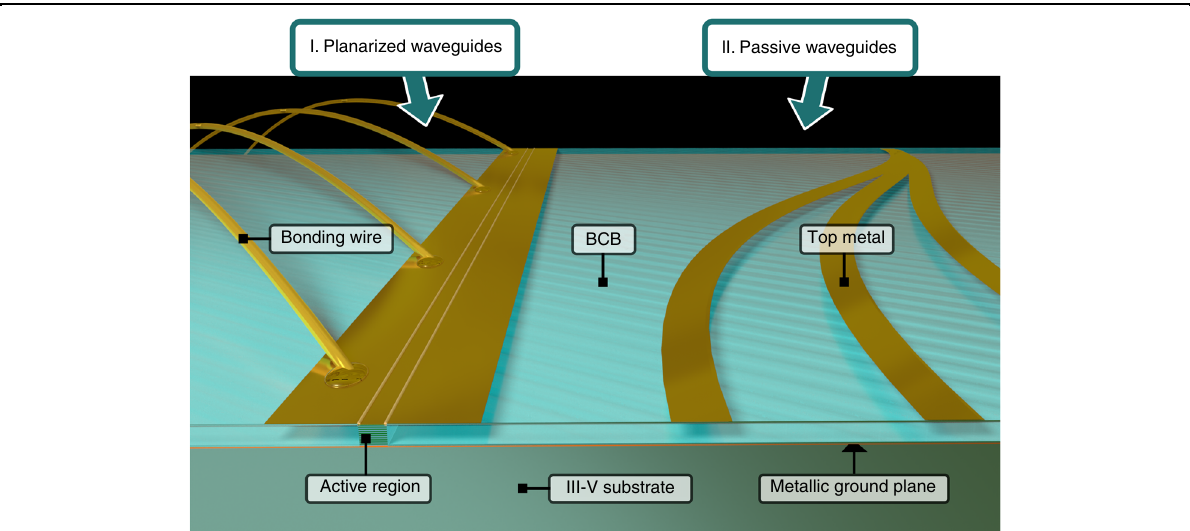
Fig. 1 Our new platform for broadband coherent THz photonics is based on planarized active and passive waveguides embedded in BCB, a low-loss polymer. I . The planarized active waveguide consists of a standard double metal waveguide encompassed in BCB and an extended top contact metallization, which enables narrower active ridge geometries and the placement of bonding wires over the passive section. This con fi guration preserves the low waveguide losses of double metal waveguides while improving the dispersion, RF and thermal properties (see text for details). II . Passive waveguides can also be fabricated, consisting of metallic stripes on top of BCB, which provide con fi nement and guide the optical mode. These can be used to co-integrate active and passive elements on the same